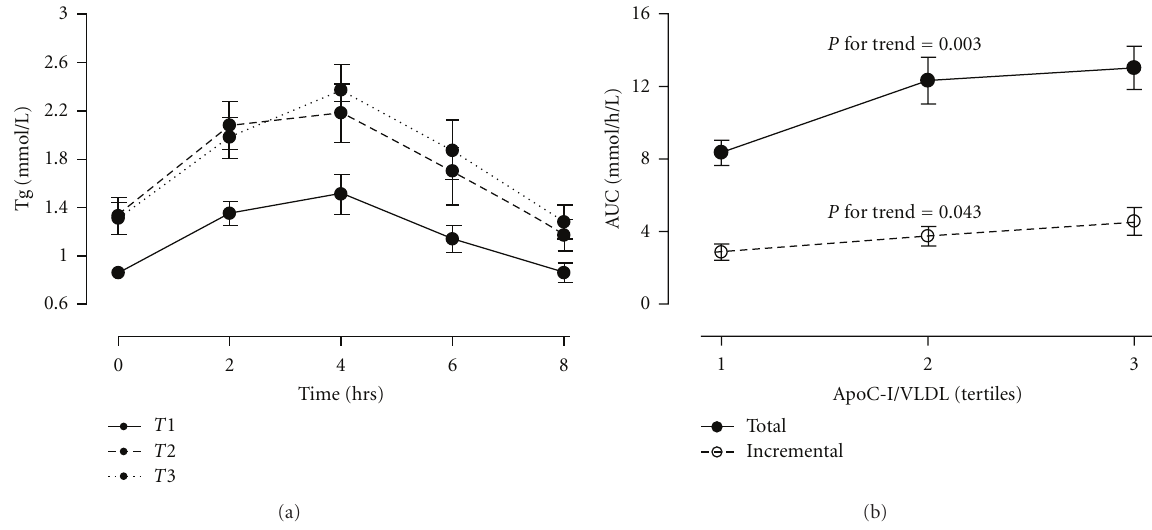
Figure 3: Line graphs showing serum concentrations of triglycerides (Tg) over time in groups after intake of a standard high-fat meal (a) and changes in area under the curve (AUC) for serum triglycerides in the postprandial state (0–8hrs) across tertiles of the number of apoC-I per VLDL particle in the postprandial state (b). Groups (T1–T3) were defined by their respective tertiles of the number of apoC-I per VLDL particle in the postprandial state. Tertiles of the number of apoC-I per VLDL particle in the postprandial state were as follows (mean,